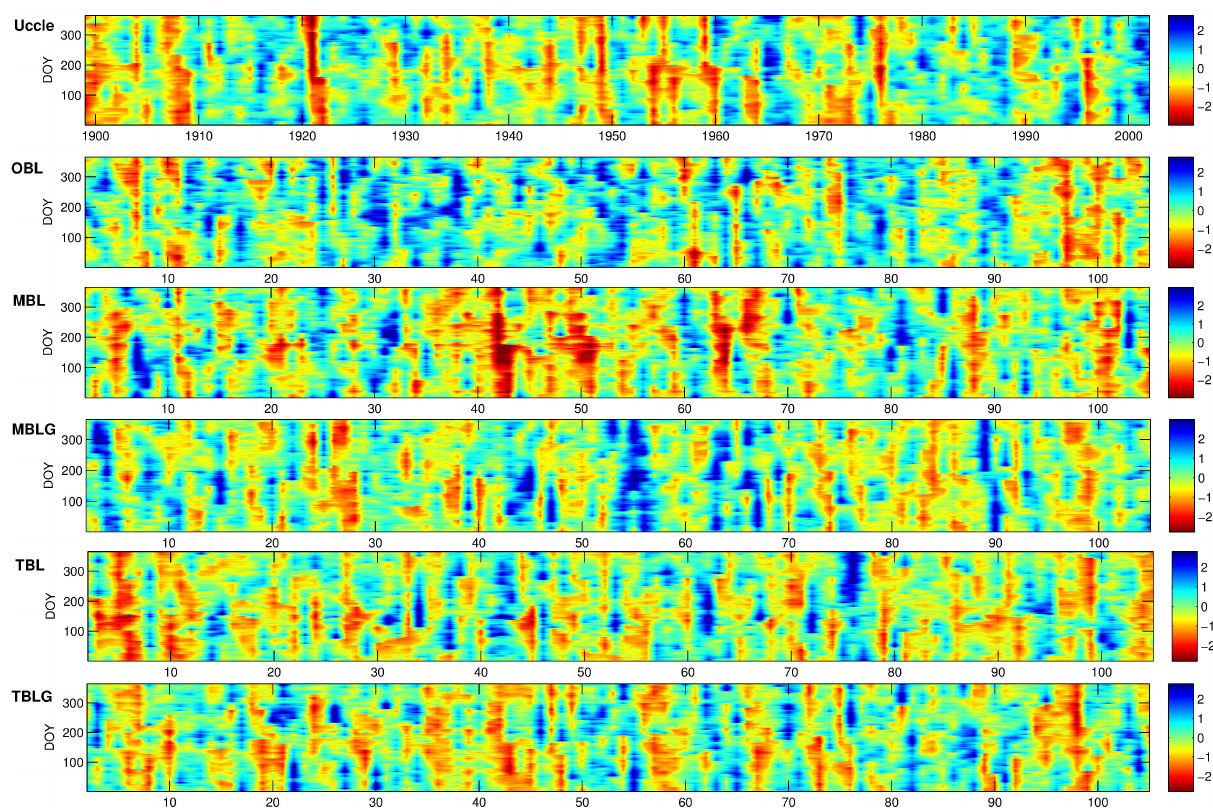
Fig. 1. Evolution of the EDI index of observed and simulated rainfall records for 104yr. The y axis corresponds to the day of the year (DOY), while the x axis displays the